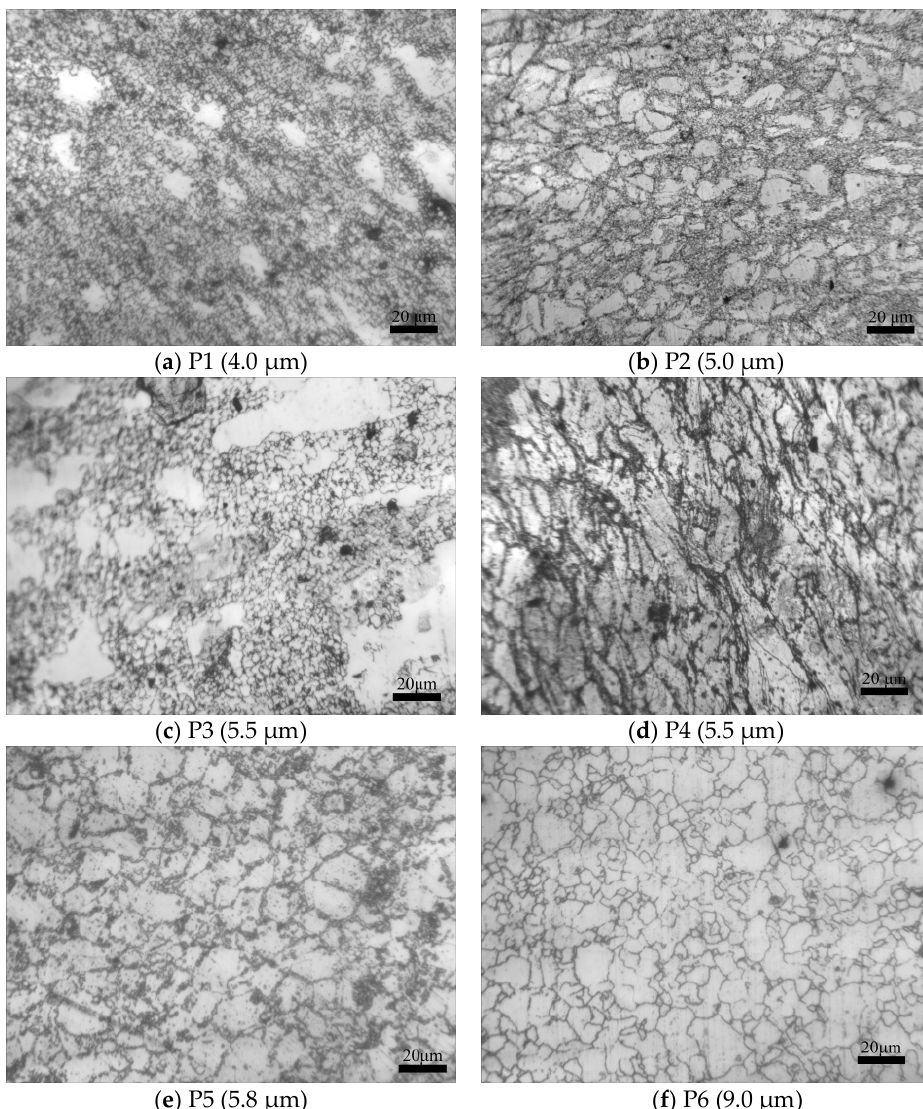
Figure 17. Average grain size of 21-4N in the forging process 1–6.